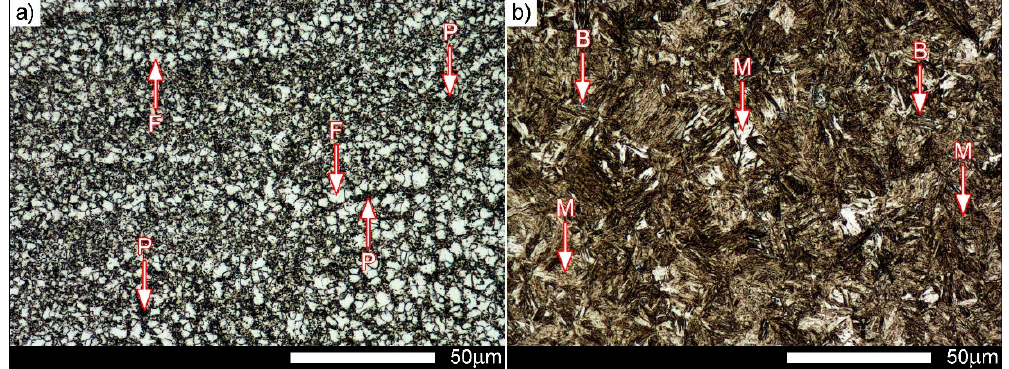
Figure 11. Microstructures of the Hardox 600 joint within the fusion zone—FZ1 in Figure 3: ( a ) after welding; and ( b ) after welding and heat treatment. Light microscopy, etched with 2% HNO 3 . Metals 2017 , 7 , 349